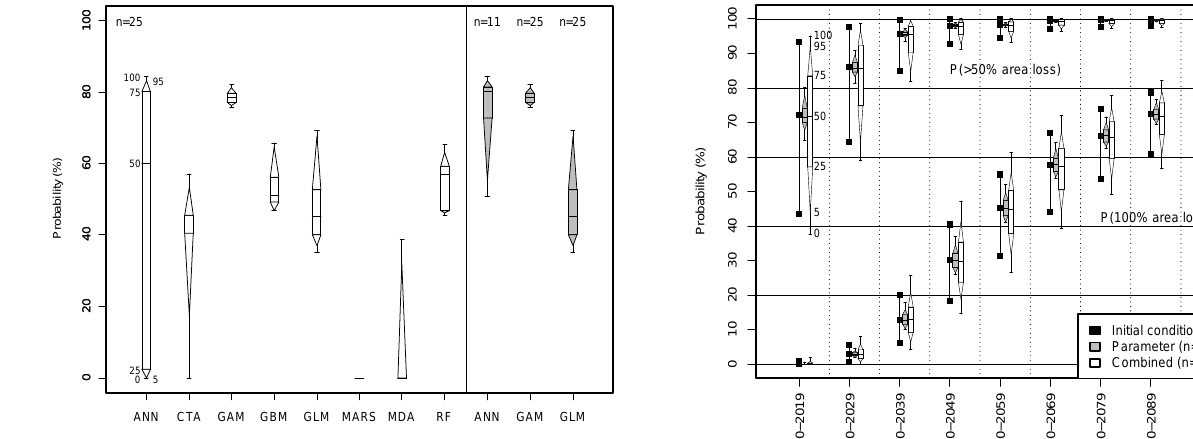
Fig. 6. Parameter uncertainty in estimating the probability that all palsa area becomes unsuitable by 2080–2099 for eight model types using all ensemble members calibrated for the period 1961–1990 ( n =25; white boxplots) and using only the “plausible” ensemble members (grey boxplots; see text for definition). Probabilities were estimated by evaluating impact response surfaces for the Grand Ensemble ( n =10000) with SRES A1B forcing. Boxplots show lower quartile, median and upper quartile; triangle peaks show the 5th and 95th percentiles (defining 90% confidence intervals); whiskers delimit the smallest and largest values.